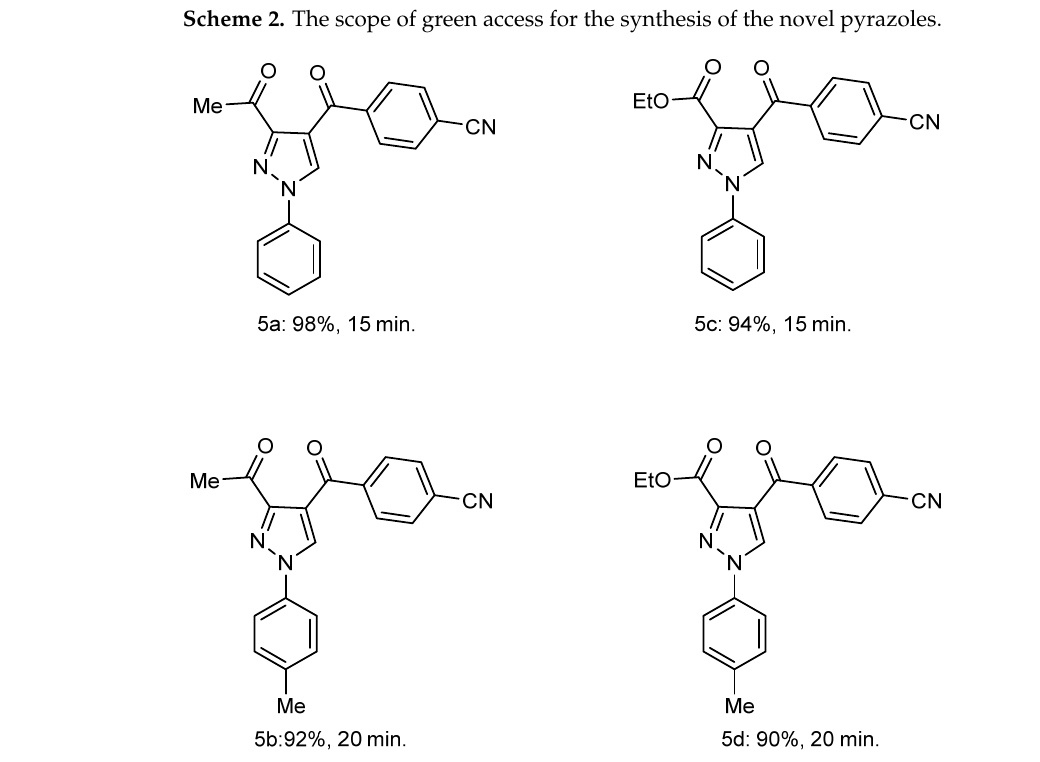
Scheme 2. The scope of green access for the synthesis of the novel pyrazoles.